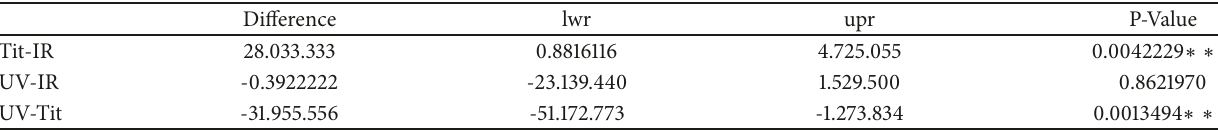
Figure 1: Diagnostic graphs of the assumptions of the variance analysis model. Table 5: Tukey test among raw